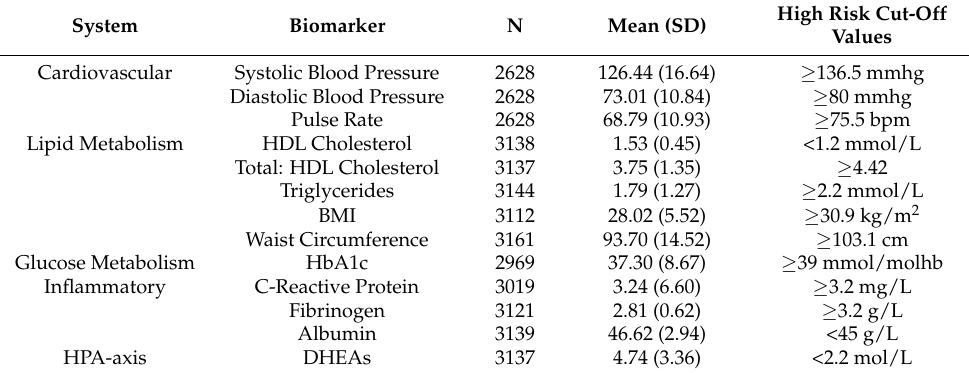
Table 1. Biomarker